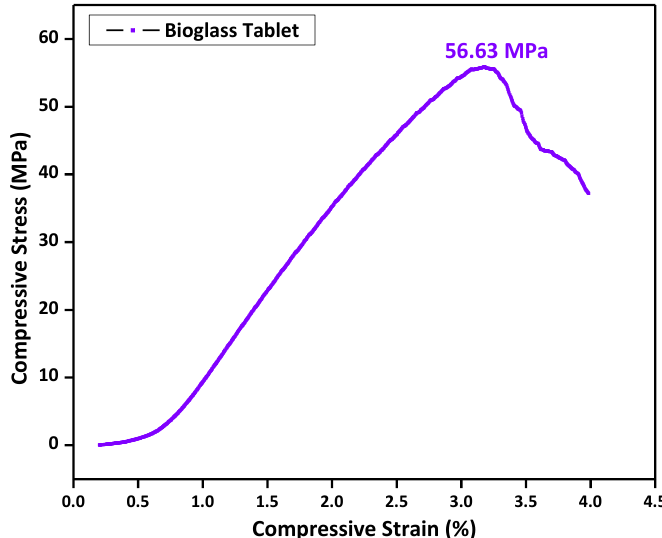
Figure 7. Compressive Stress – Strain Curve of Bioglass